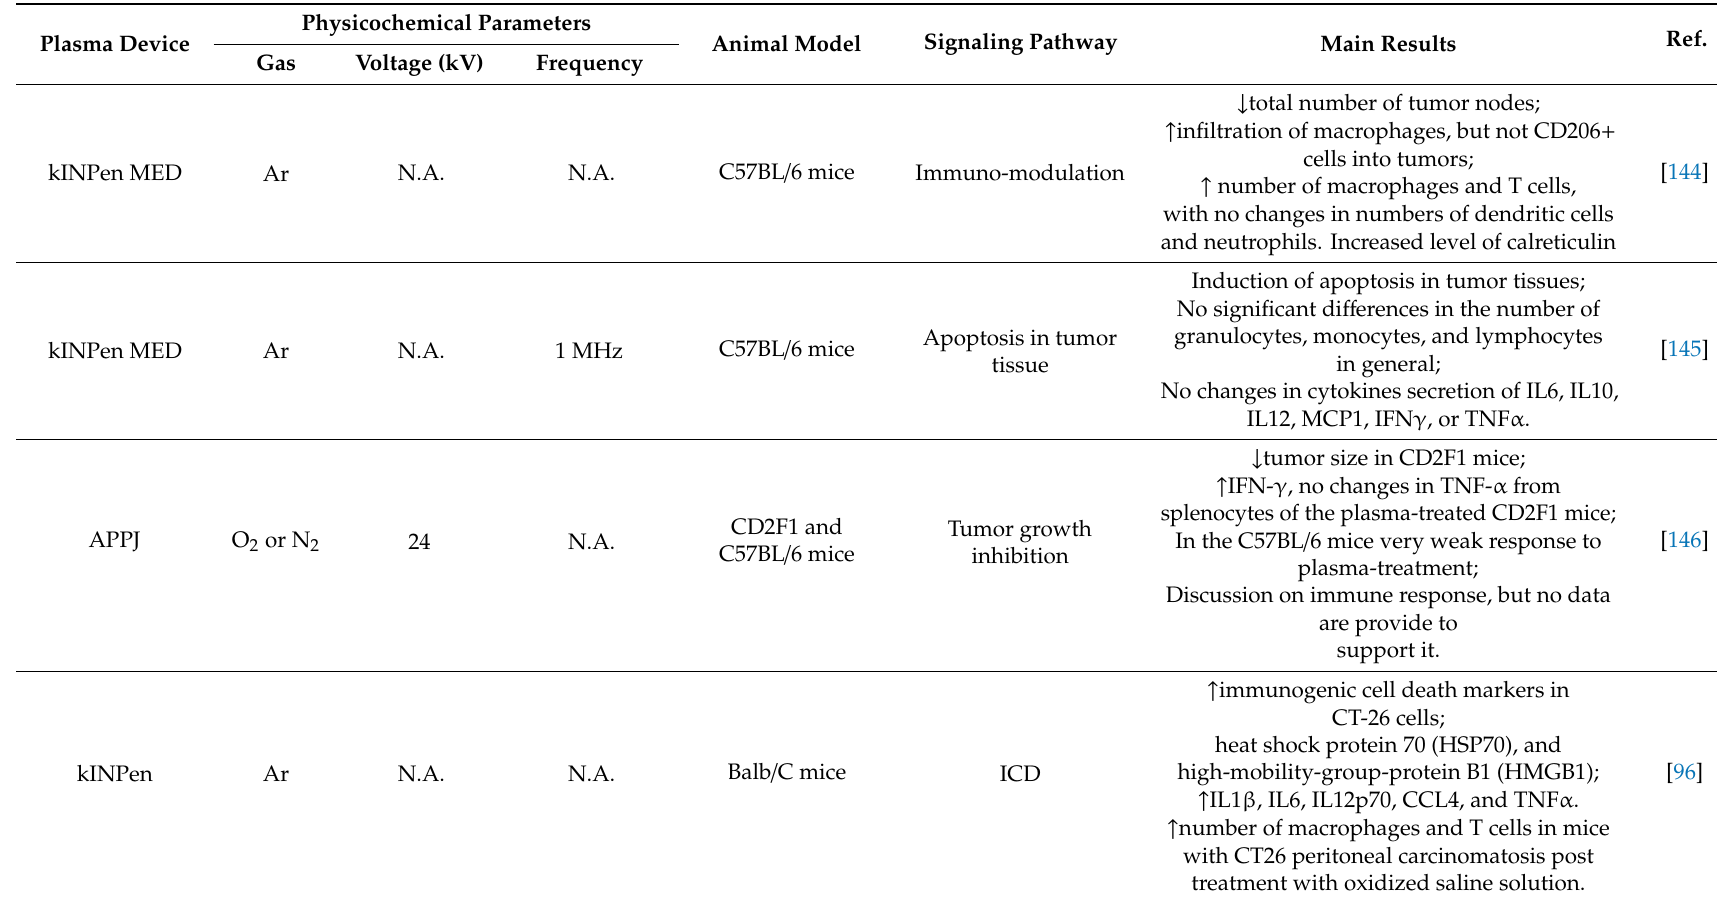
Table 4. Summary of NTP modulation of immune cell activity in